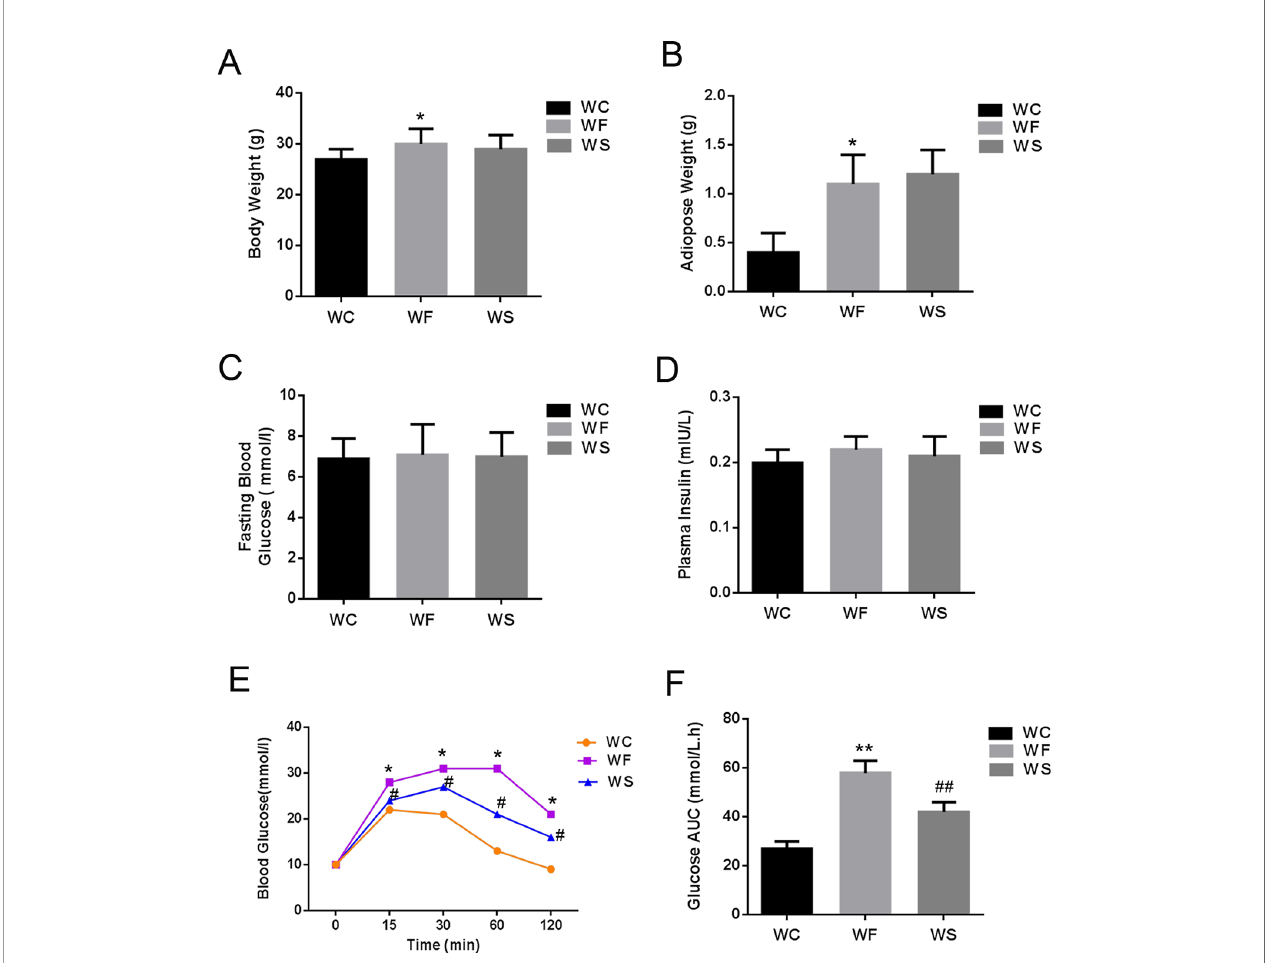
FIGURE 1 | Silibinin cannot reduce the body weight of mice, but can improve glucose metabolism. (A) High-fat diet increased the weight of mice in the WF group, while the weight of mice in the WS group was not decreased when silibinin was added; (B) High-fat diet increased the adipose weight of mice in the WF group, while the weight of mice in the WS group was not decreased when silibinin was added; (C) The comparison of the average fasting blood glucose levels of three groups of mice; (D) There was no statistical difference in fasting insulin levels among the three groups; (E) The blood glucose of the WF group increased signi fi cantly at 15 min, 30 min, 60 min, and 120 min compared with the WC group, and the addition of silibinin signi fi cantly reduced its blood glucose concentration; (F) The comparison of the glucose AUC of the three groups of mice; *P < 0.05 and **P < 0.01 vs WC; # P < 0.05 and ## P < 0.01 vs WF; WC, normal diet; WF, high fat diet; WS, high fat diet +